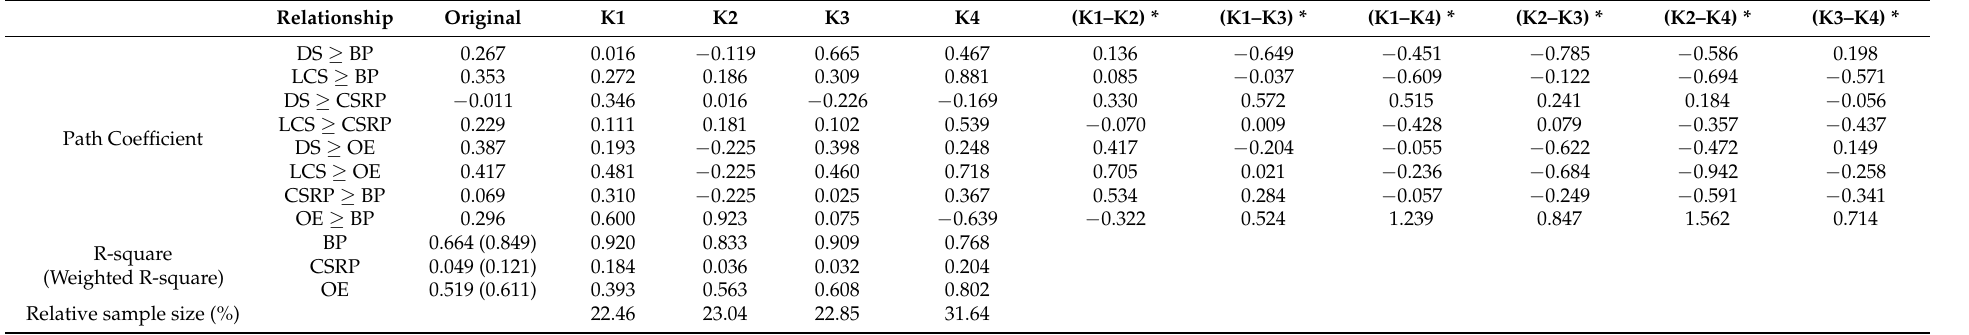
Table 5. Path coefficient of POS